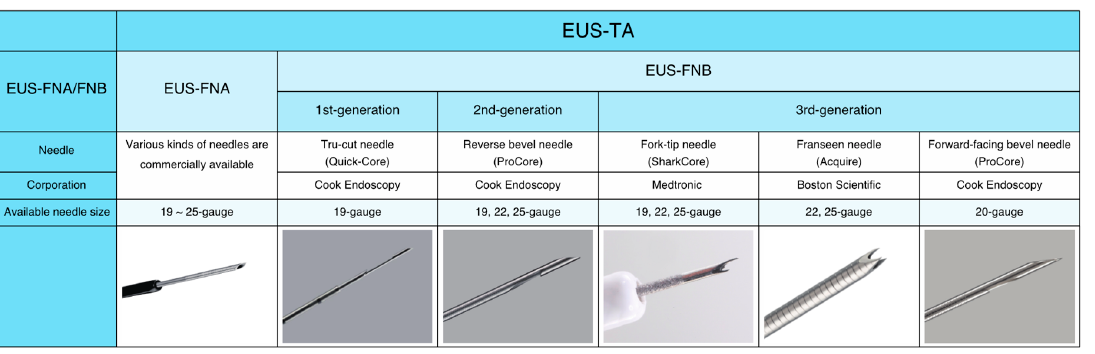
Figure 4. Di ff erences in needle design between EUS-FNA and EUS-FNB Figure 4. Differences in needle design between EUS-FNA and EUS-FNB needles.